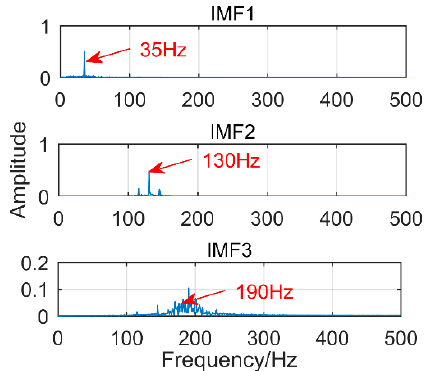
Figure 24. Frequency-domain diagram of the decomposition results obtained by MVMD.